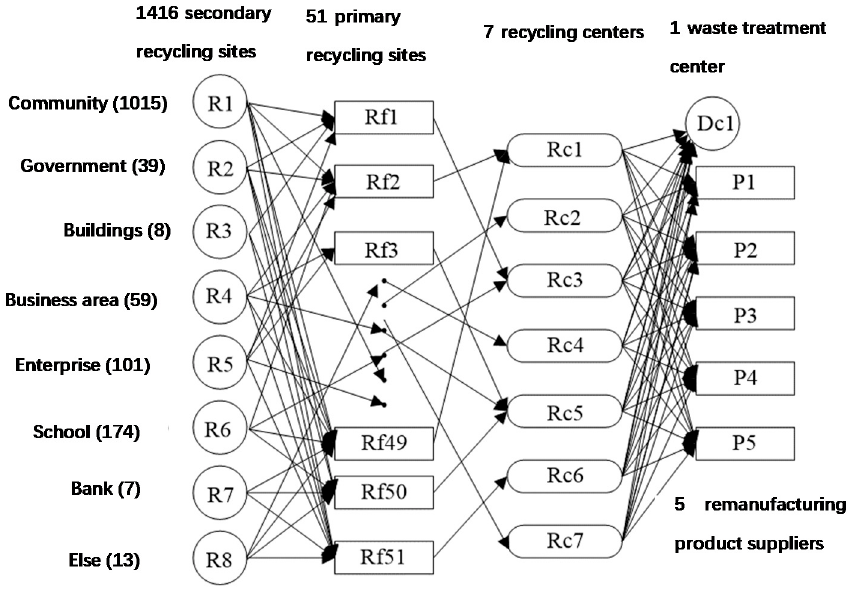
Figure 5. Electronic waste remanufacturing systems recycling network.